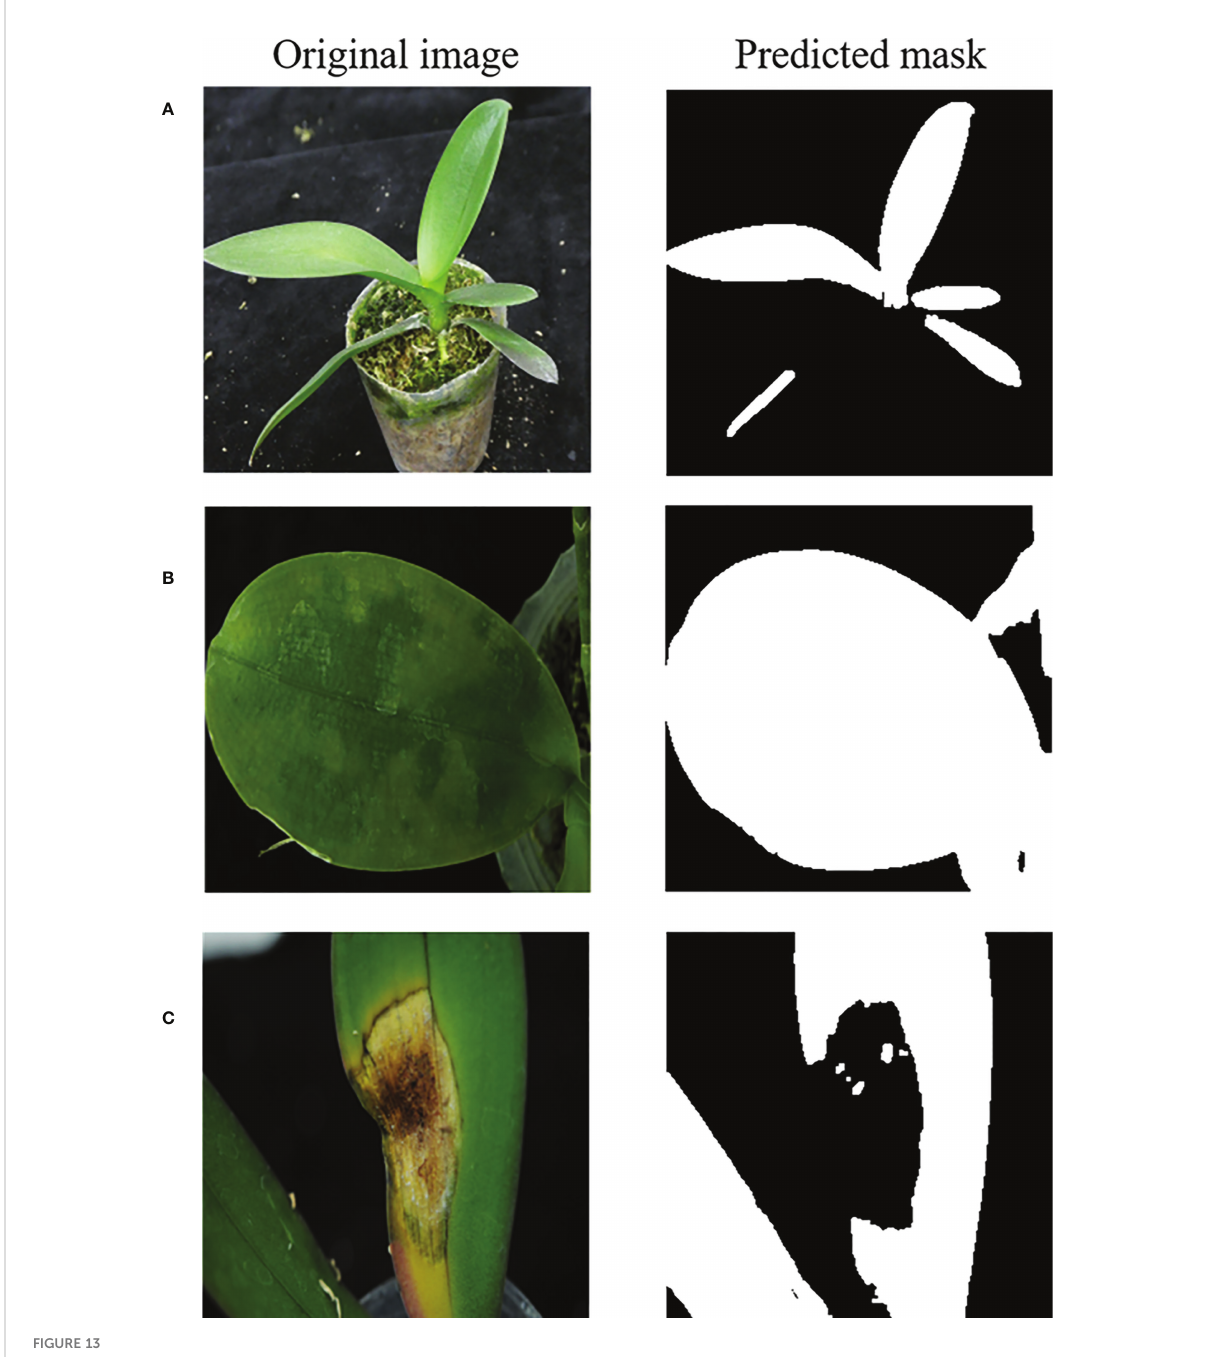
Identi fi cation accuracies of four single-stage models with